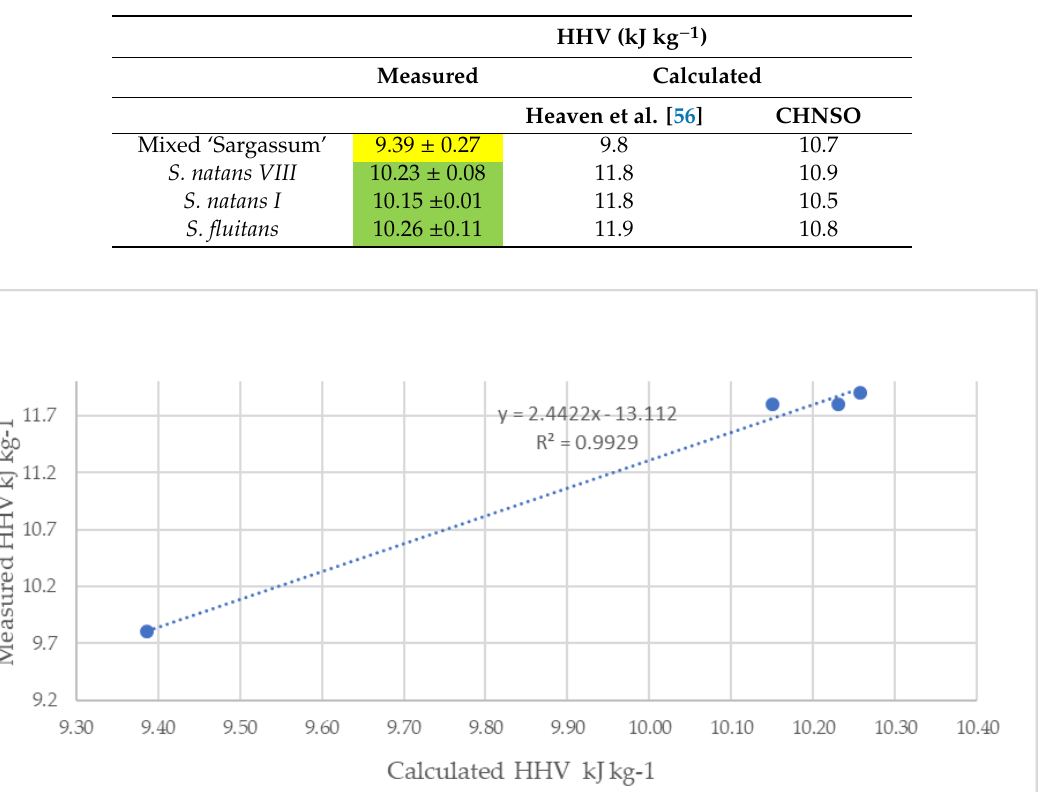
Table 11. The theoretical MP from the ‘Buswell equation’ based on CHNSO and the method of Heaven et al. [56] based on the lipid, protein and carbohydrate content (both including and excluding fibre) together with actual MP and biodegradability index (BI).